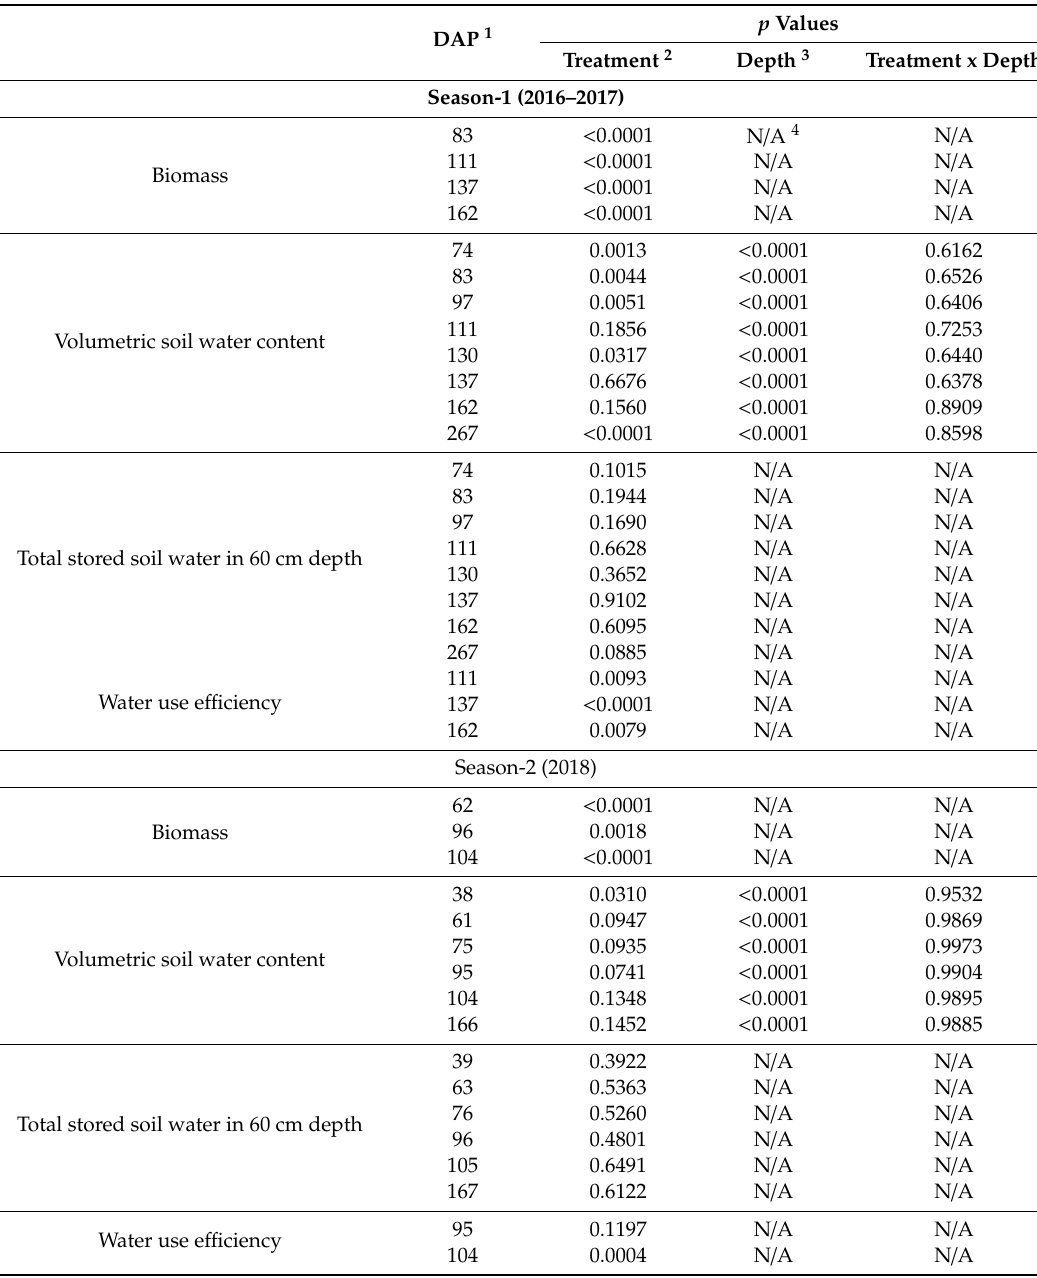
Table 3. Analysis of variance results on the e ff ects of treatments (seven cover crops and two types of fallow controls), depths at which volumetric soil water content was measured, and treatment-by-depth interaction on biomass, volumetric soil water content at various depths, total stored soil water in 60 cm depth, and / or water use e ffi